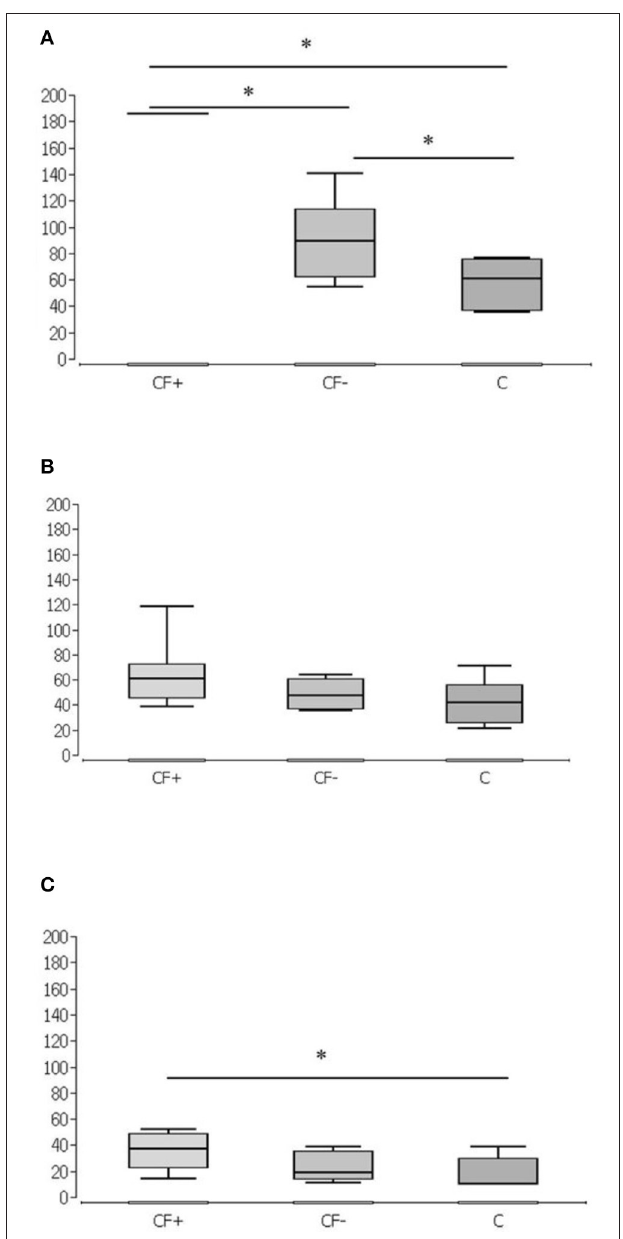
FIGURE 1 | Different spraying techniques of Colistin over time. Simultaneous spraying of colistin and fibrin glue (CF + ), consecutive spraying of colistin and fibrin glue (CF-) and without fixation of colistin by fibrin glue (C) after 1h (A) , 2h (B) , and 4h (C) . Significantly higher values in CF + group at 1h against CF- and C and in CF- against C (A) . No significant differences after 2h (B) . Significantly higher values in CF + at 4h against C ( n = 7 per group and timepoint). * p < 0.05.